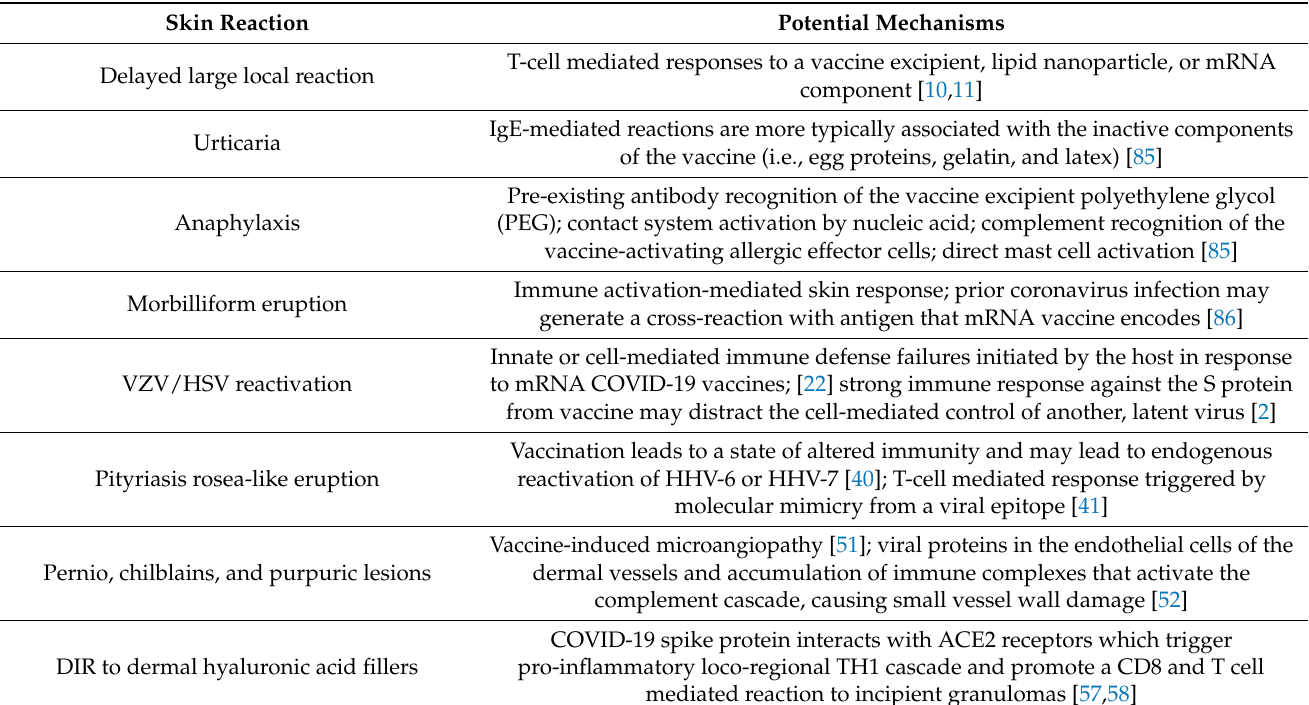
Table 3. Suggested pathogenetic mechanisms underlying COVID-19 vaccine-related cutaneous